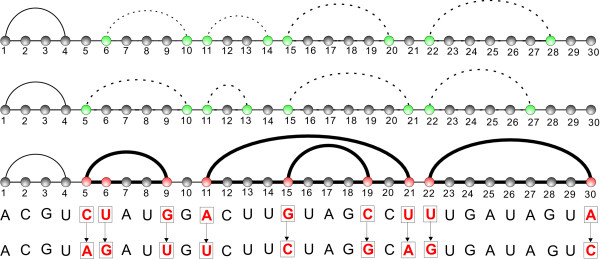
Sequence mutation. Suppose the top and middle structures represent the set of competitors and the bottom structure is target. We display λi - 1(top sequence) and its mutation, λi (bottom sequence). Two nucleotides of base pairs not contained in T are colored green, nucleotides subject to mutations are colored red.